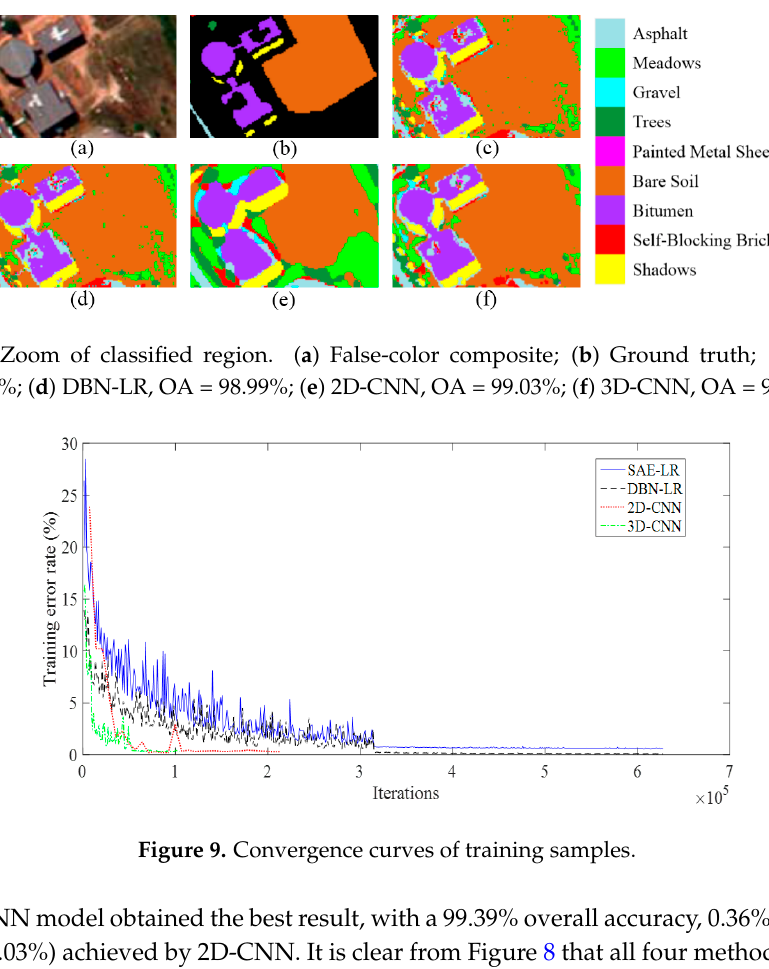
Figure 7. Classification results of Pavia University scene. ( a ) False-color composite. ( b ) Ground truth. ( c ) SAE-LR, OA = 98.46%. ( d ) DBN-LR, OA = 98.99%. ( e ) 2D-CNN, OA = 99.03%. ( f ) 3D-CNN, OA = 99.39%.